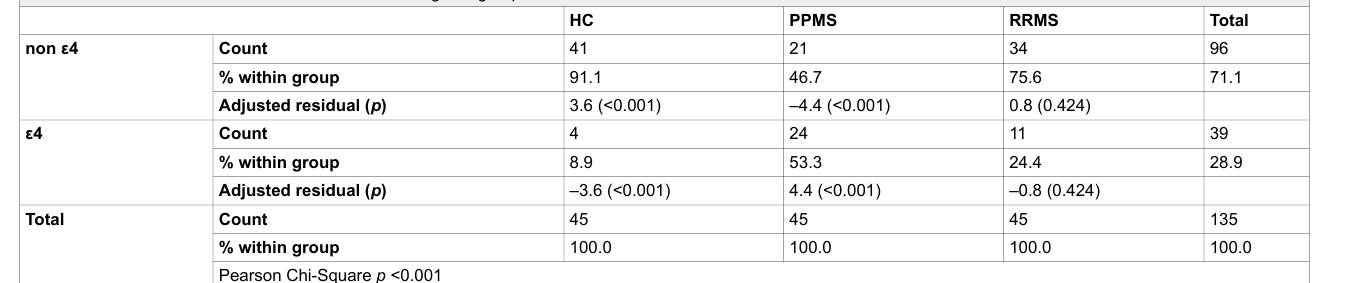
Table 4b: The occurrence of the ε4 allele in the investigated groups.